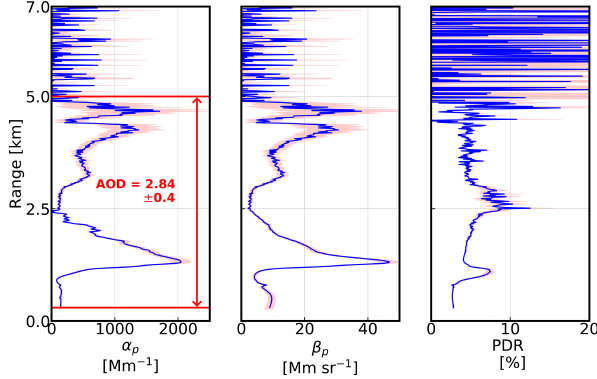
Figure 14. Warm sector. Optical properties calculated from lidar signals using the Fernald–Klett method. Data from Watnall on 16 October from 11:15 to 11:44. The lidar ratio in the lower 2.5km was set to the height-resolved values retrieved using the Raman in- version method (shown in the top row of Fig. 13); above 2.5km the value was set to